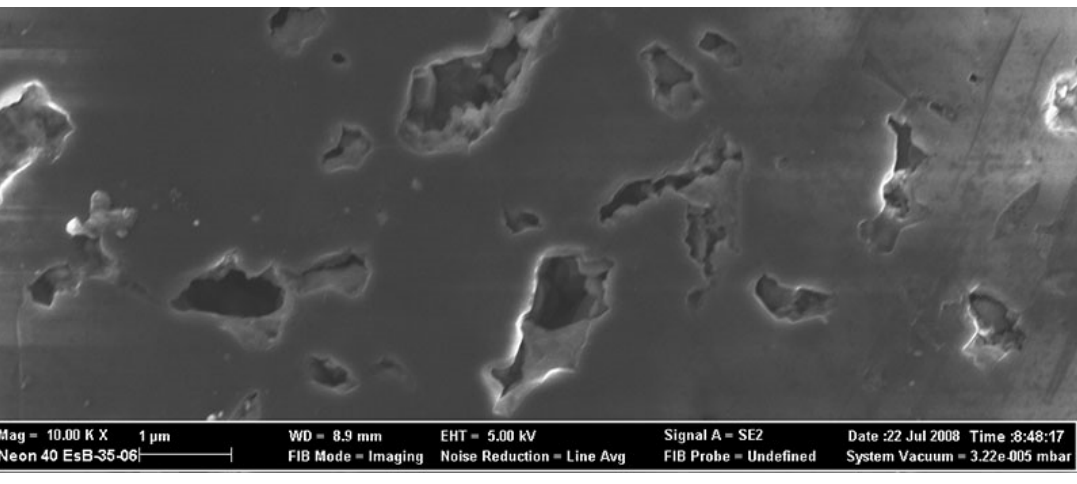
Figure 2. SEM image of ground and polished PCD surface, 5 µ m class (dark grey areas are the bridged diamond grains with cavities where also traces of cobalt show up in lighter shades).